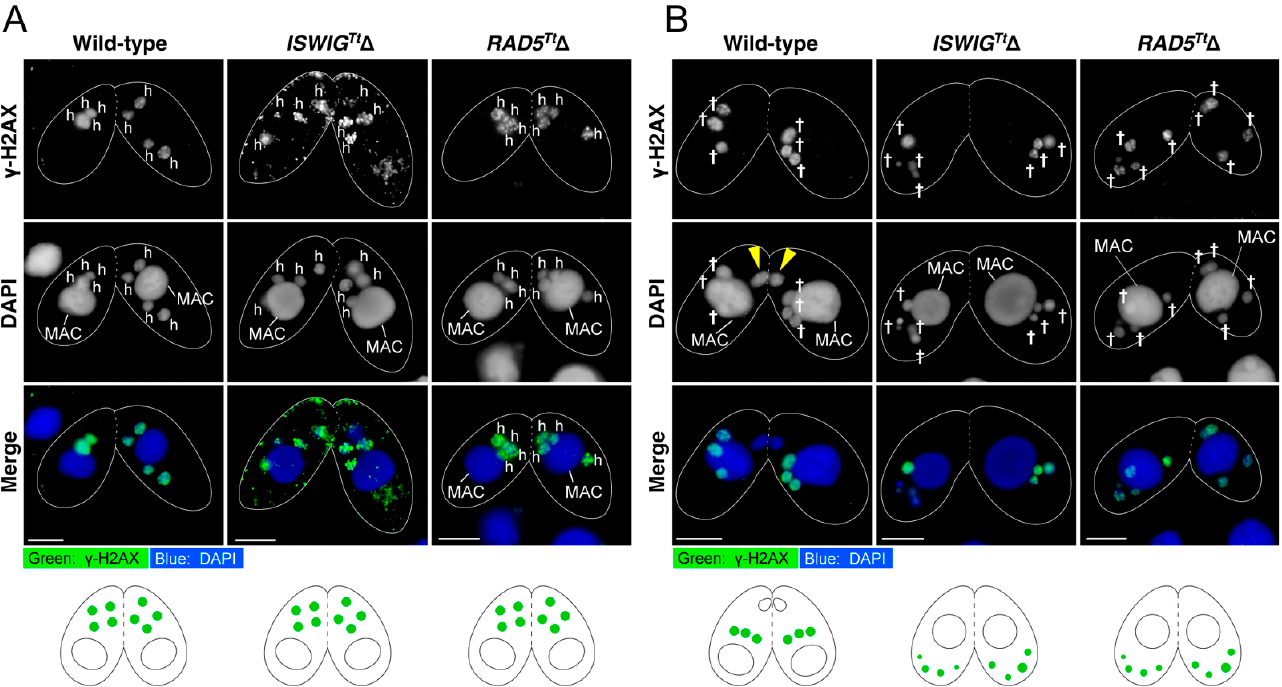
Figure 4. The post-meiotic γ -H2AX formation was not affected but persisted in the ISWIG Tt Δ pairs and the RAD5 Tt Δ pairs. ( A ) γ -H2AX foci appeared at the post-meiosis stage; h-hMIC resulting from MIC meiosis; the scale bar denotes 10 μ m. ( B ) γ -H2AX foci disappeared in the selected hMIC in wild type pairs at 6 h from the initiation of conjugation. In contrast, it persisted in degrading hMICs of the ISWIG Tt Δ pairs and the RAD5 Tt Δ pairs in which hMIC selection failed. Schematic diagrams of the appearance of γ -H2AX foci are shown below each micrograph set. Triangle—the selected hMIC; †—unselected hMIC; the scale bar denotes 10 μ m.